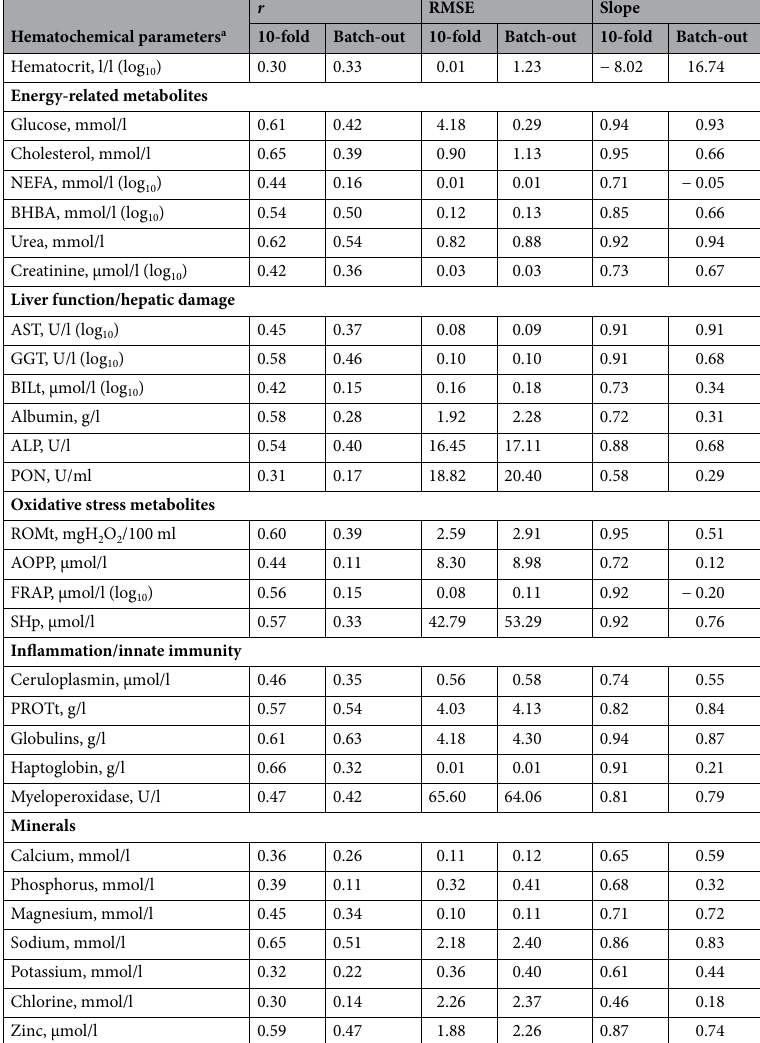
Table 2. Near-infrared AfiLab milk prediction performance considering the systematic effect of days in milk and parity through different cross-validation scheme for hematochemical parameters using machine learning. All the presented results are the average of the different folds (10 for the 10-fold and 5 for the leave-one-batch- out). RMSE = root mean square error. a NEFA non-esterified fatty acids, BHBA β-hydroxybutyric acid, AST aspartate aminotransferase, GGT γ-glutamyl transferase, BILt total bilirubin, ALP alkaline phosphatase, PON paraoxonase, ROMt total reactive oxygen metabolites, AOPP advanced oxidation protein products, FRAP ferric reducing antioxidant power, SHp thiolic groups, PROTt total